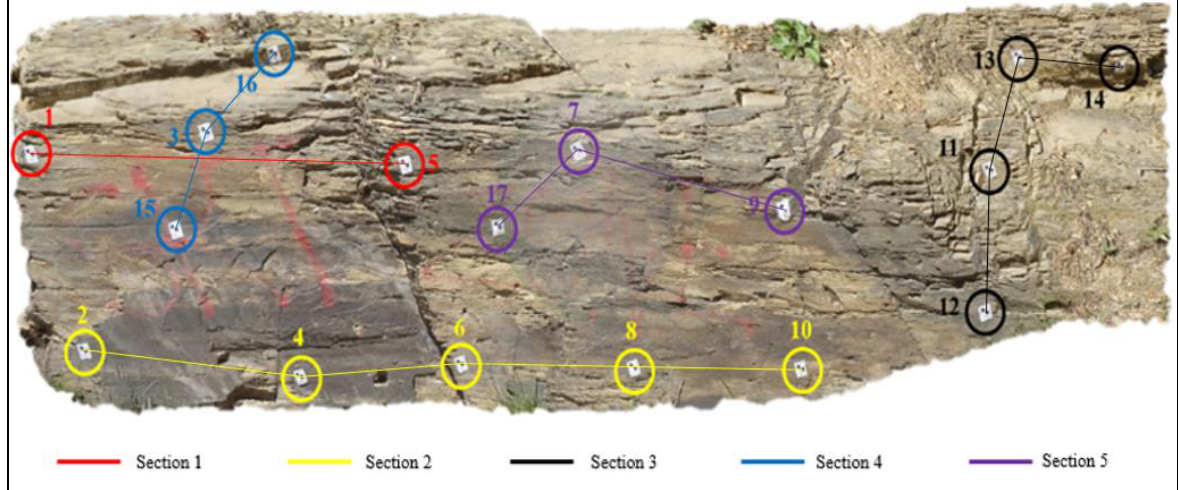
Figure 5. Points where five cross-sections